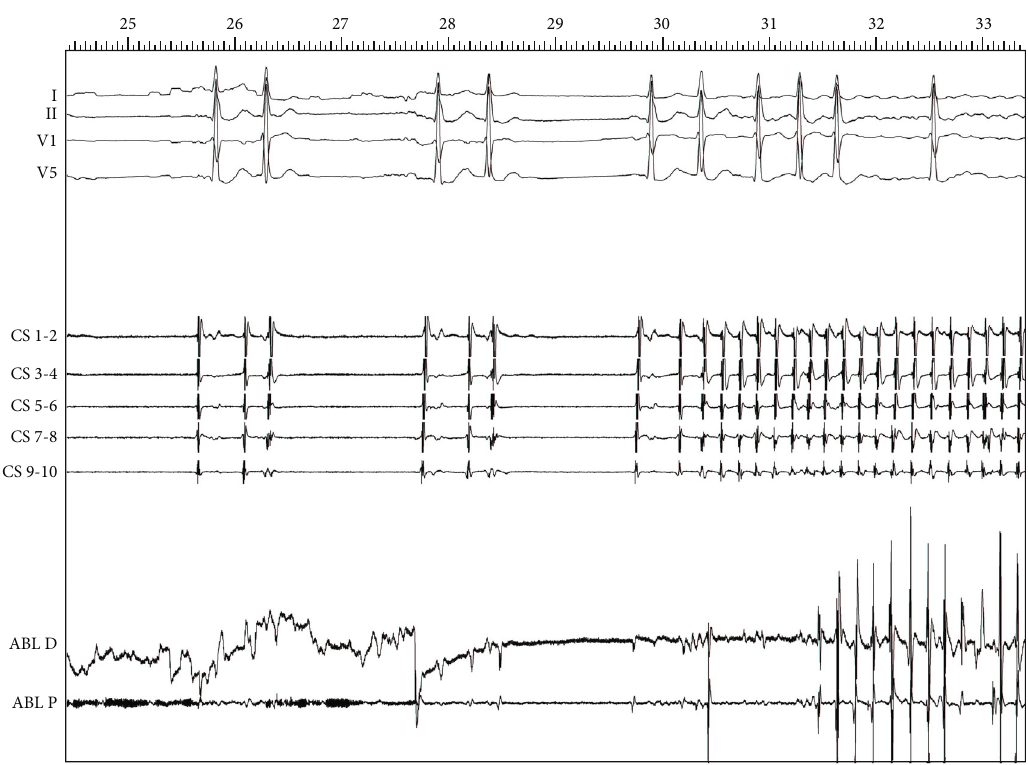
Figure 1: “ P on T ” phenomena as AF trigger during catheter positioning (I-II-V1-V6: ECG lead; CS: coronary sinus decapolar diagnostic catheter tracings; ABL: bipolar ablation catheter tracings).